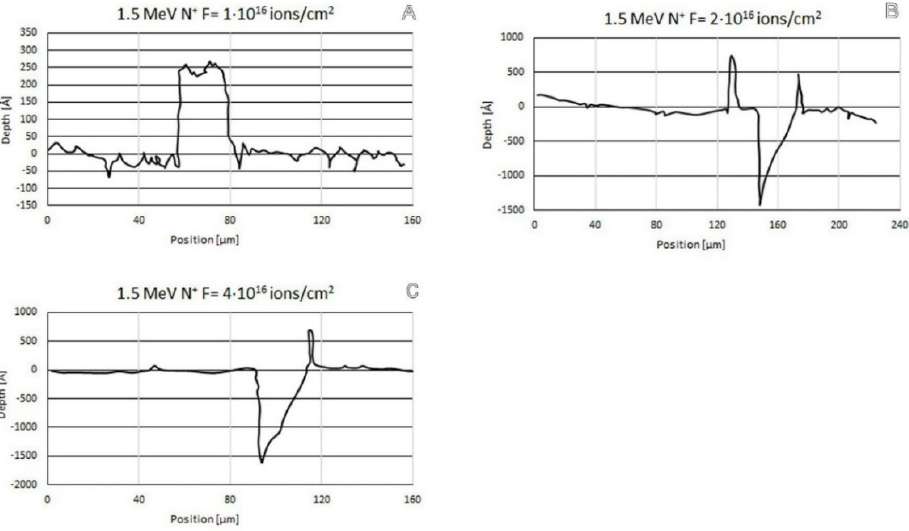
Figure 9. Profiles of a channel waveguide implanted through a silicon mask using 1.5 MeV N + ions. Fluences were 1 · 10 16 ( A ), 2 · 10 16 ( B ) and 4 · 10 16 ions/cm 2 ( C ).